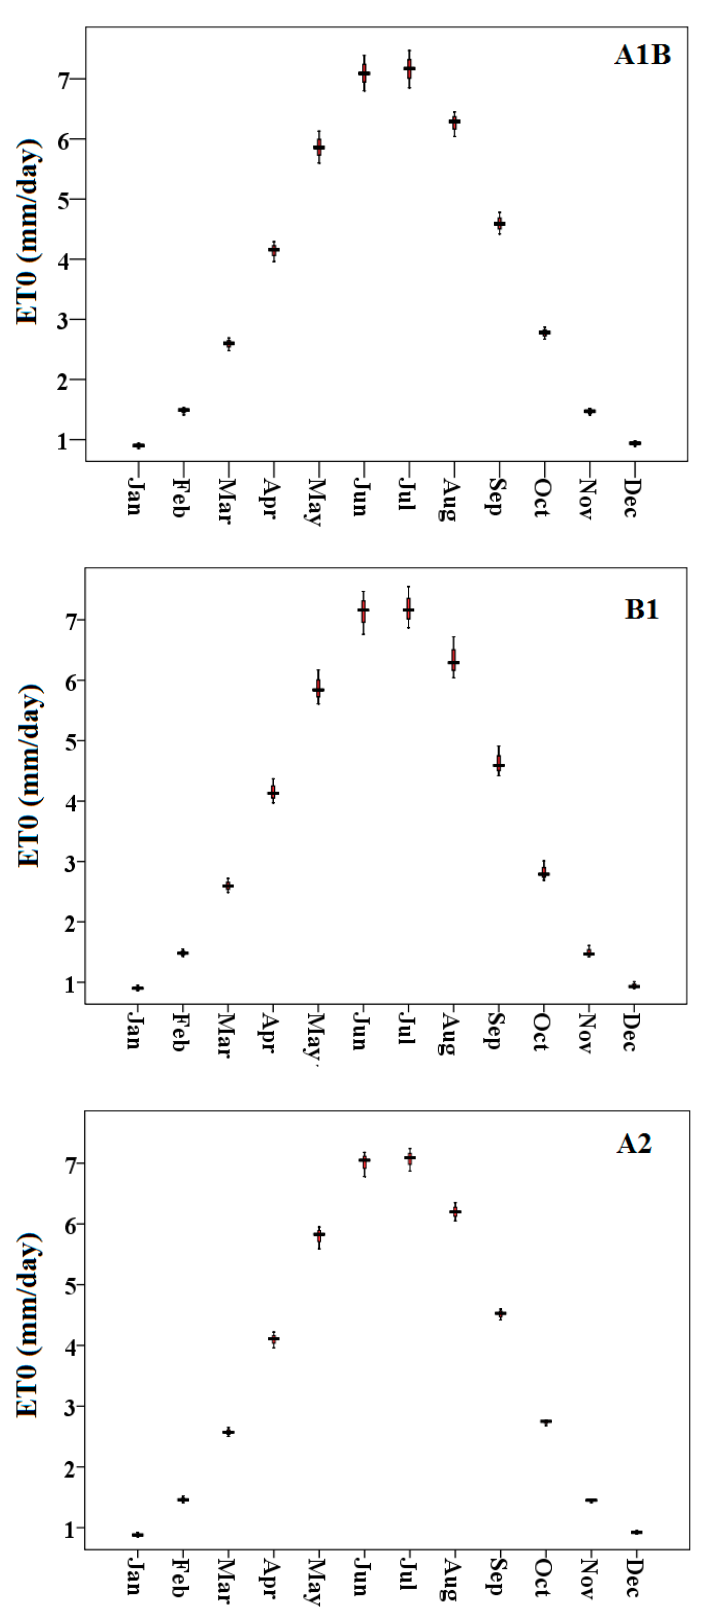
Figure 5. The box plot charts for evaluating model prediction uncertainties